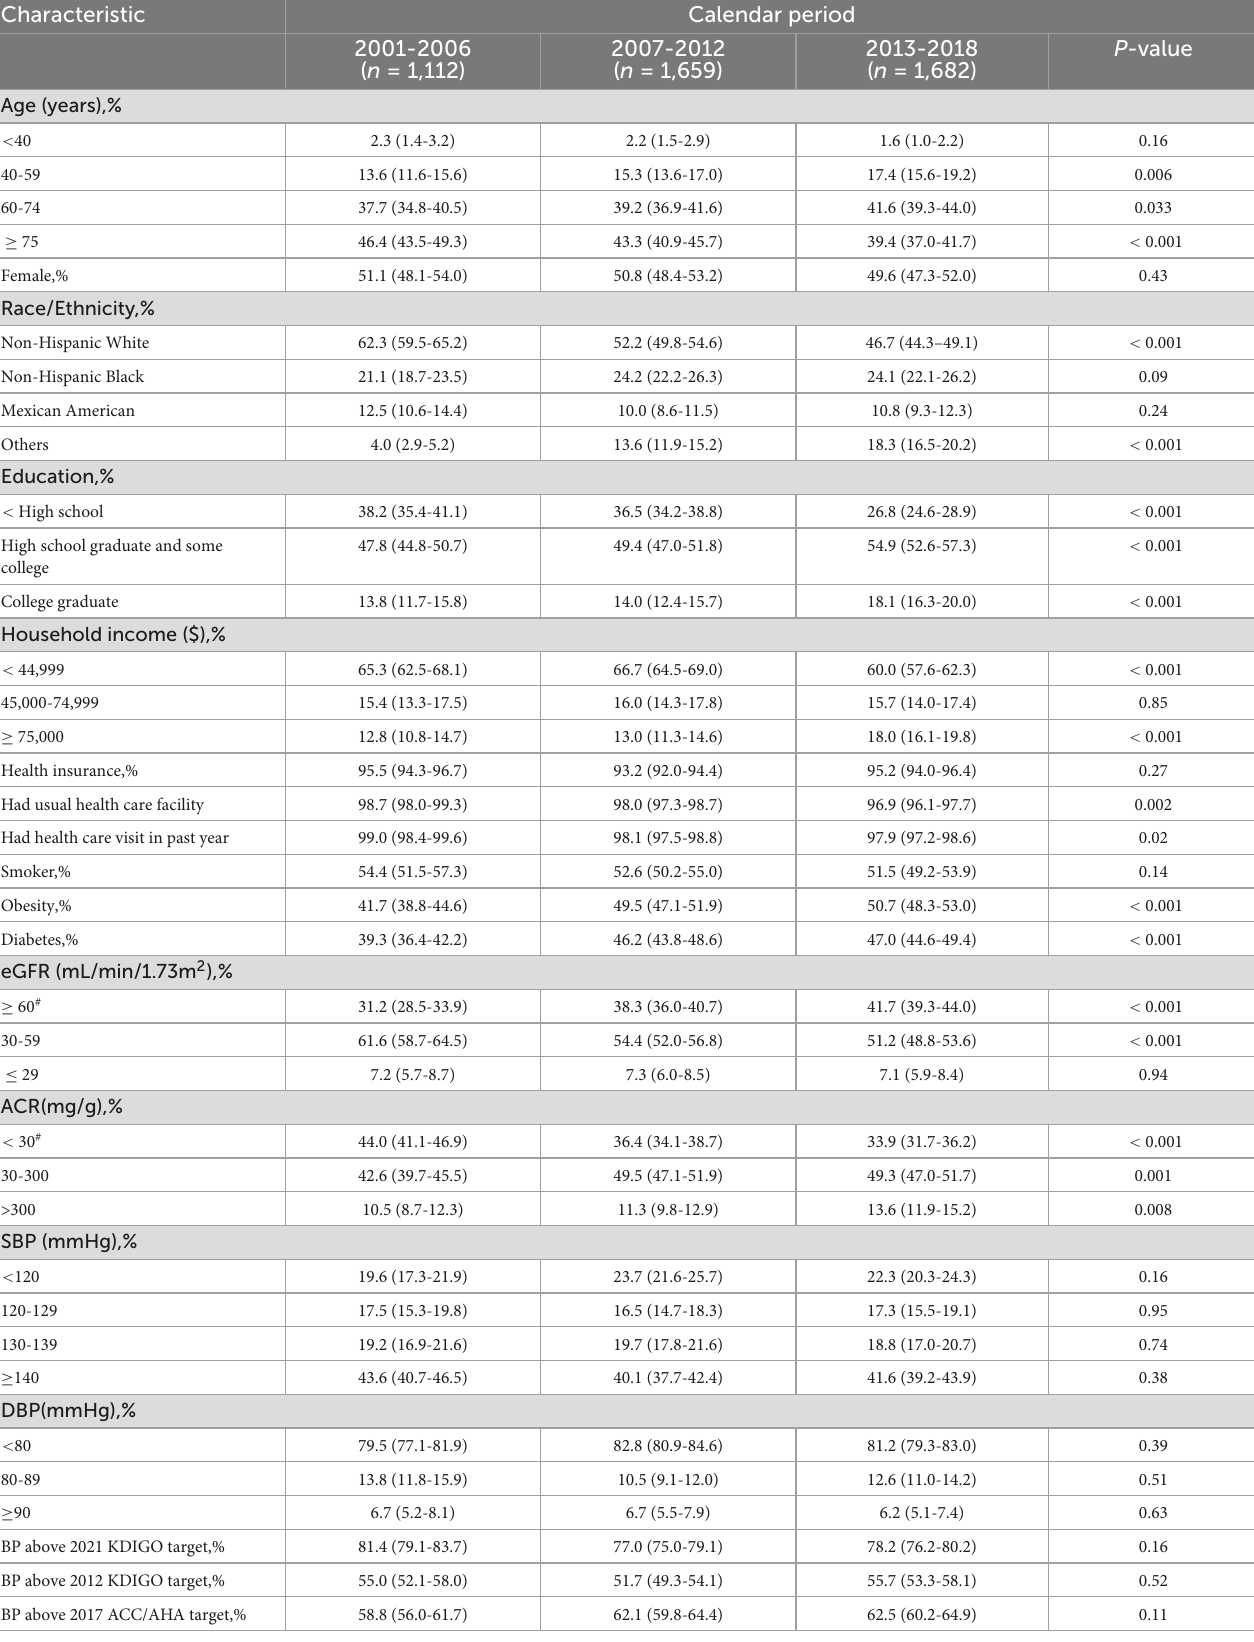
TABLE 1 Characteristics of US adults with CKD taking antihypertensive agent in NHANES 2001-2006, 2007-2012, and 2013-2018.